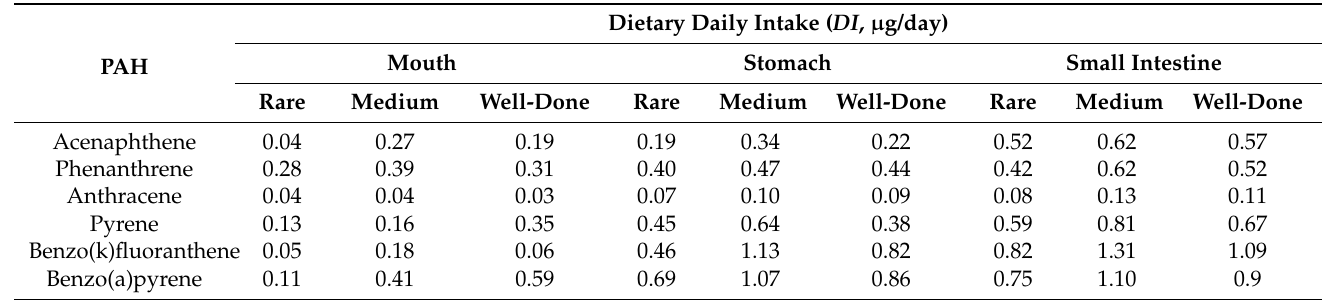
Table 5. Daily dietary intake of PAHs via consumption of grilled chicken.